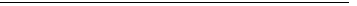
and Ξ 0 [3, 21], c c